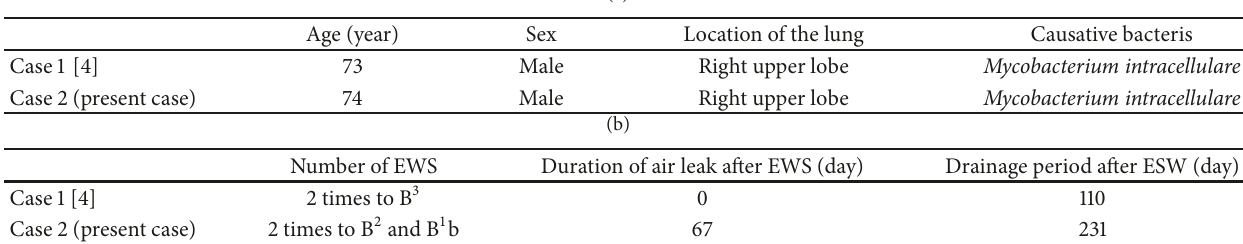
Table 1: Patient information and clinical features treated with EWS to pyopneumothorax due to NTM with RA.